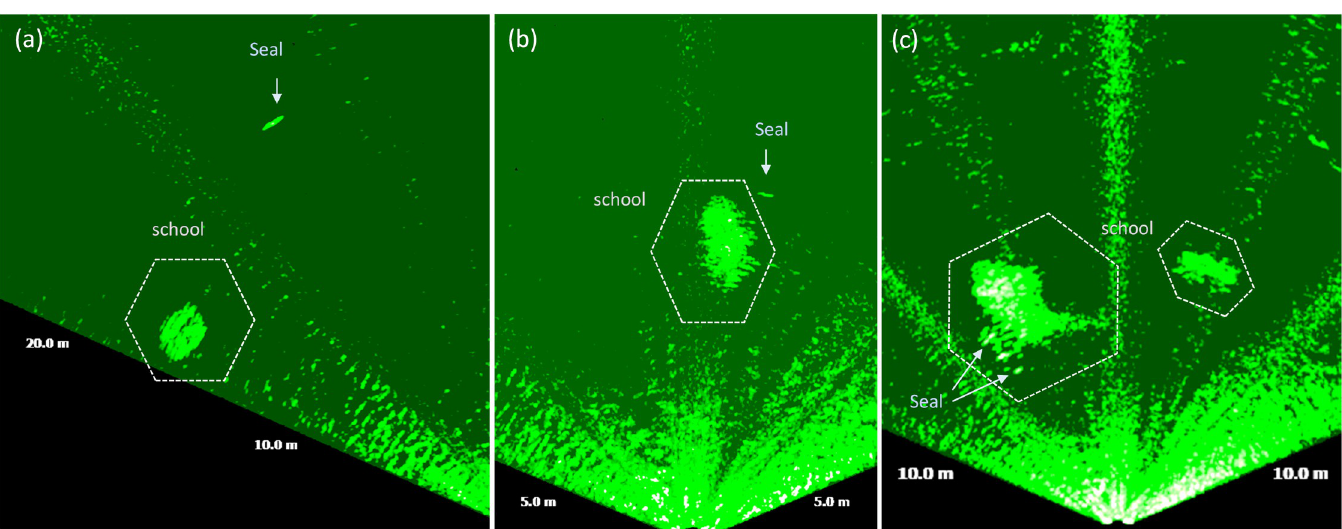
Fig 15. Acoustic images showing seals diving into schools of mid-size fish: (a) a school with 2.5 m of diameter and a seal of ca. 1.3 m of length, observed on 27/08/16 at 16:20 UTC; (b) school with ca. 3.5 m of dimeter and a seal of ca.1 m, observed on 27/08/16 at 09:18 UTC; (c) school with ca. 10 m of diameter and seals of ca. 1 m, observed on 27/08/2016 09:20